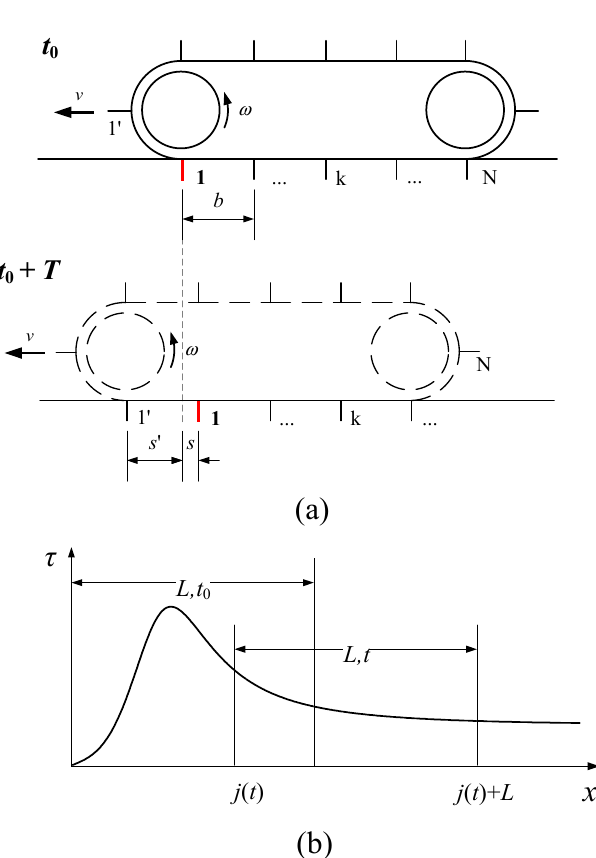
Figure 2. Dynamic traction model: ( a ) periodicity of the DPNC; ( b ) dynamic traction calculation model.